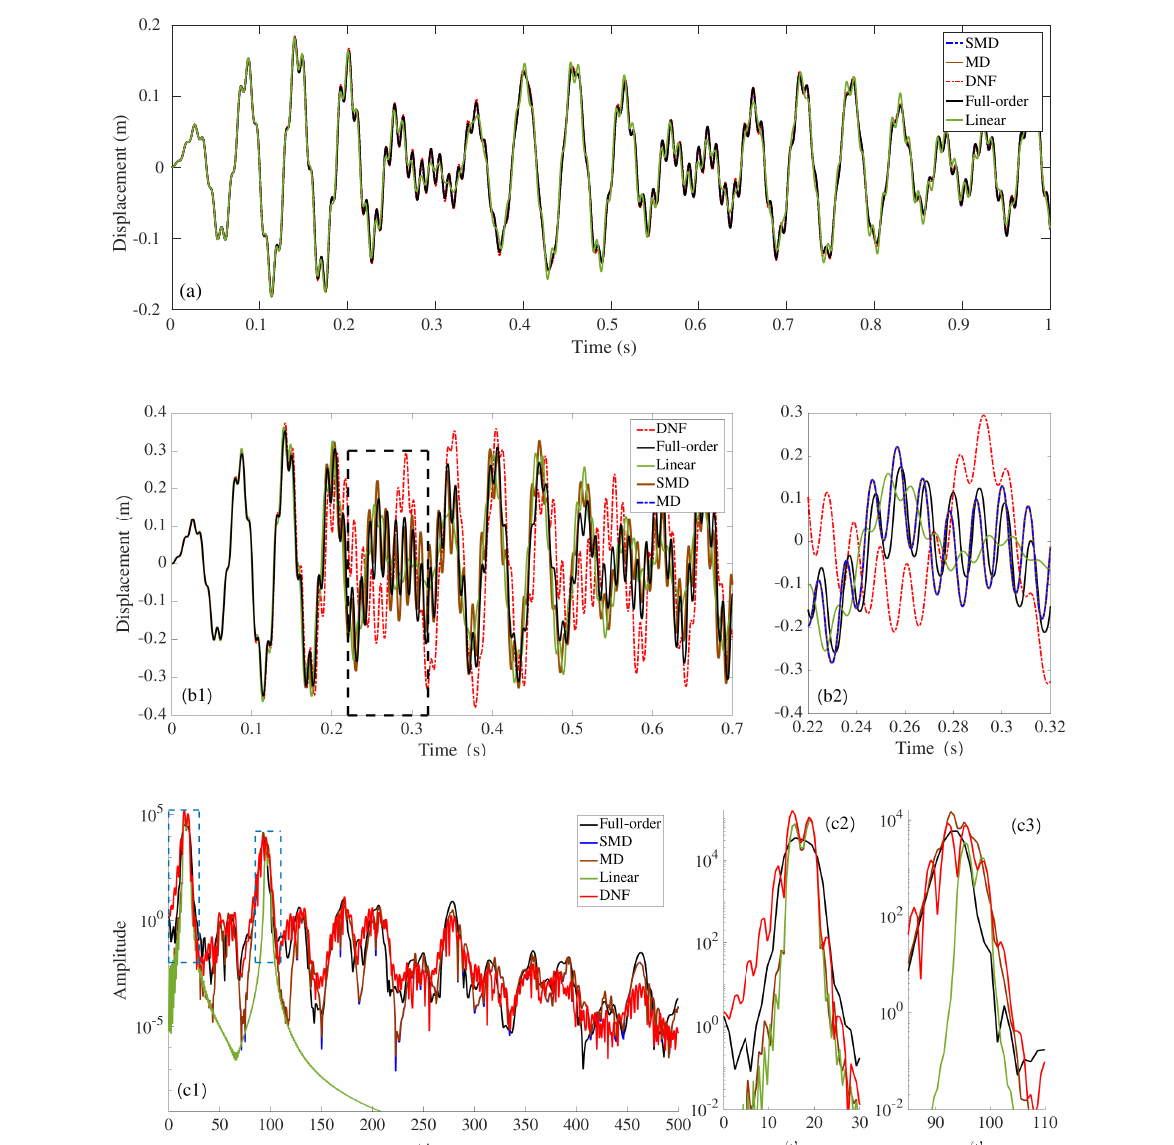
Figure 14. Time evolution of the vertical displacement of a point at the tip end of the cantilever beam in response to an applied concentrated force with a temporal content of f ( t ) = F 0 ( sin ( 1.21 ω 1 t ) + sin ( 0.97 ω 3 t )) . The reference solution (in black) is compared to three different ROMs built with two modes corresponding to master coordinates 1 and 3; blue: QM–SMD, brown: QM–MD, red: DNF. Shown in green is the full-order model assuming a linear restoring force. ( a ) F 0 = 400 N. (b) F 0 = 800 N. ( c ) The frequency content of the time signals is shown in ( b ) for F 0 = 800